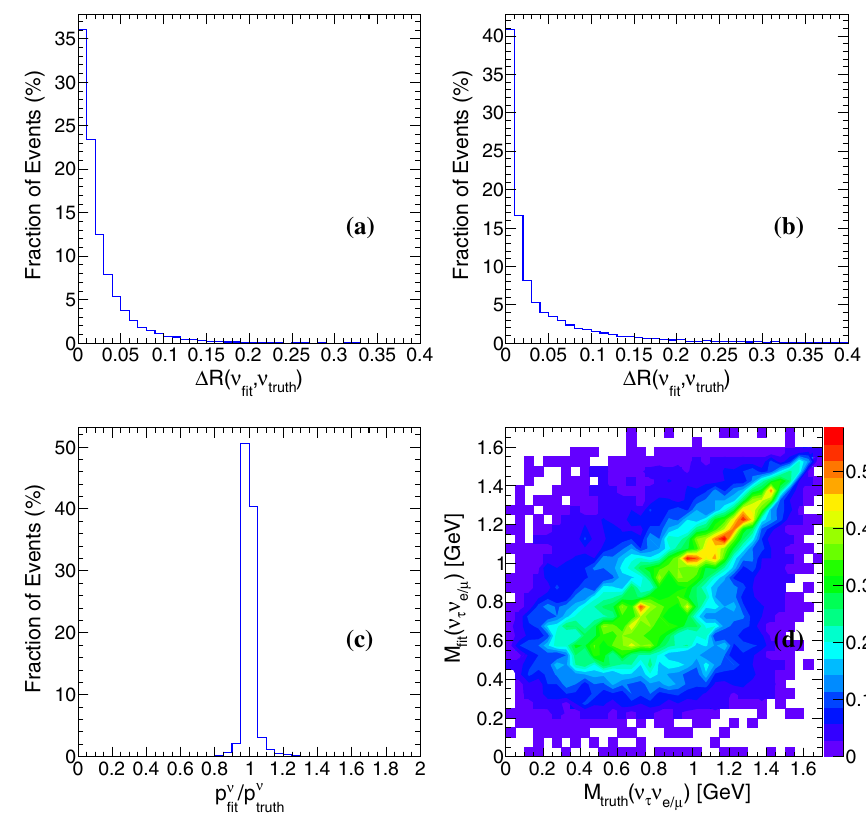
Fig. 4 The Δ R between the reconstructed and true neutrino (or di-neutrino) momenta for the τ → (cid:3)νν ( a ) and τ → πν + ρν ( b ) decays, the ratio of the reconstructed to true di-neutrino momentum for the τ → (cid:3)νν decay ( c ), and the 2-D distribution of the true versus reconstructed di-neutrino mass ( d ), in the (cid:3) + π/ρ and Z → (cid:3)(cid:3) channels